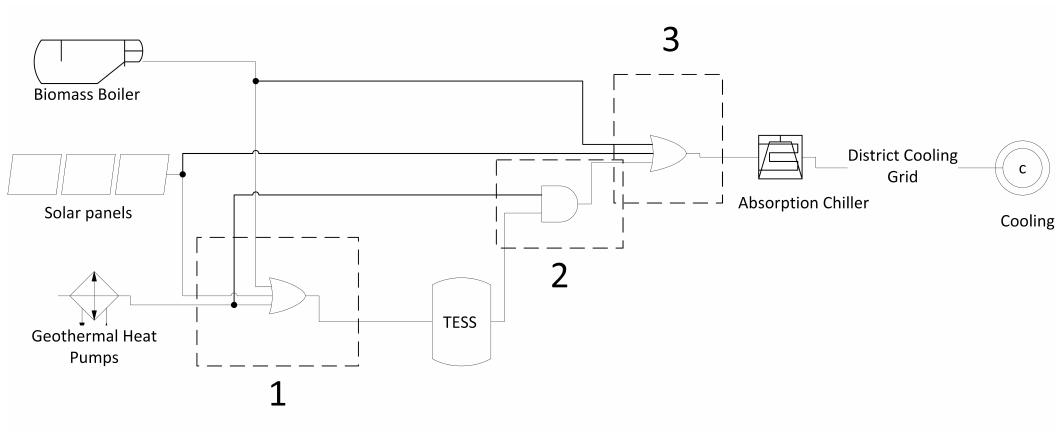
Figure 8. Expanded P-graph including the equipment to be used and logic gate numeration, for the cooling